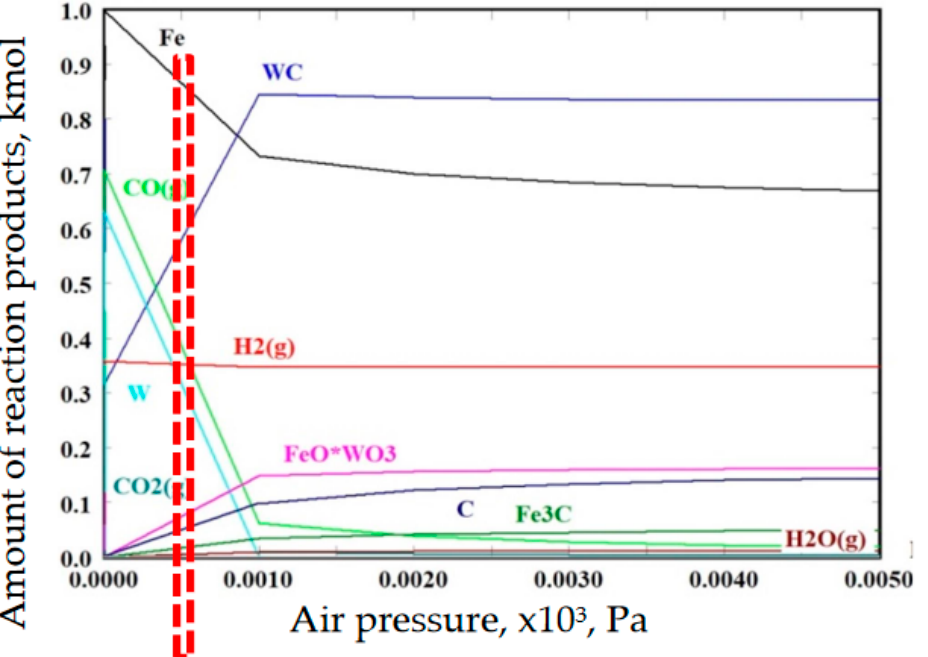
Figure 22. Modeling of the reaction products in WC + 5% C + Fe system at 500 °C in low vacuum obtained by using humid air and its gradual pressure reduction. The low vacuum conditions seem to be obtained at pressure below 100 Pa (1 × 10 − 3 bar) (reprinted with permission from Ref. [27], 2022, Elsevier). Similar to all previous cases, the vertical frame indicates the conditions generating reaction products identified by Raman spectroscopy in transfer layer.